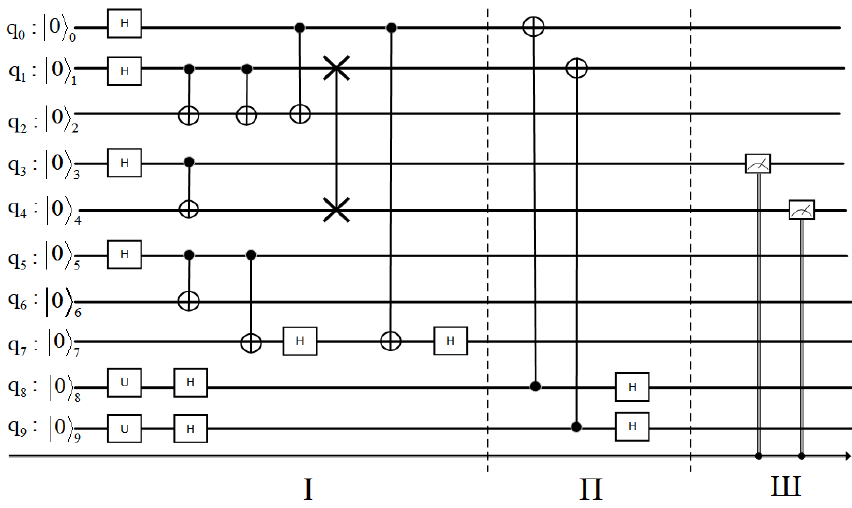
Figure 8. The complete process of the